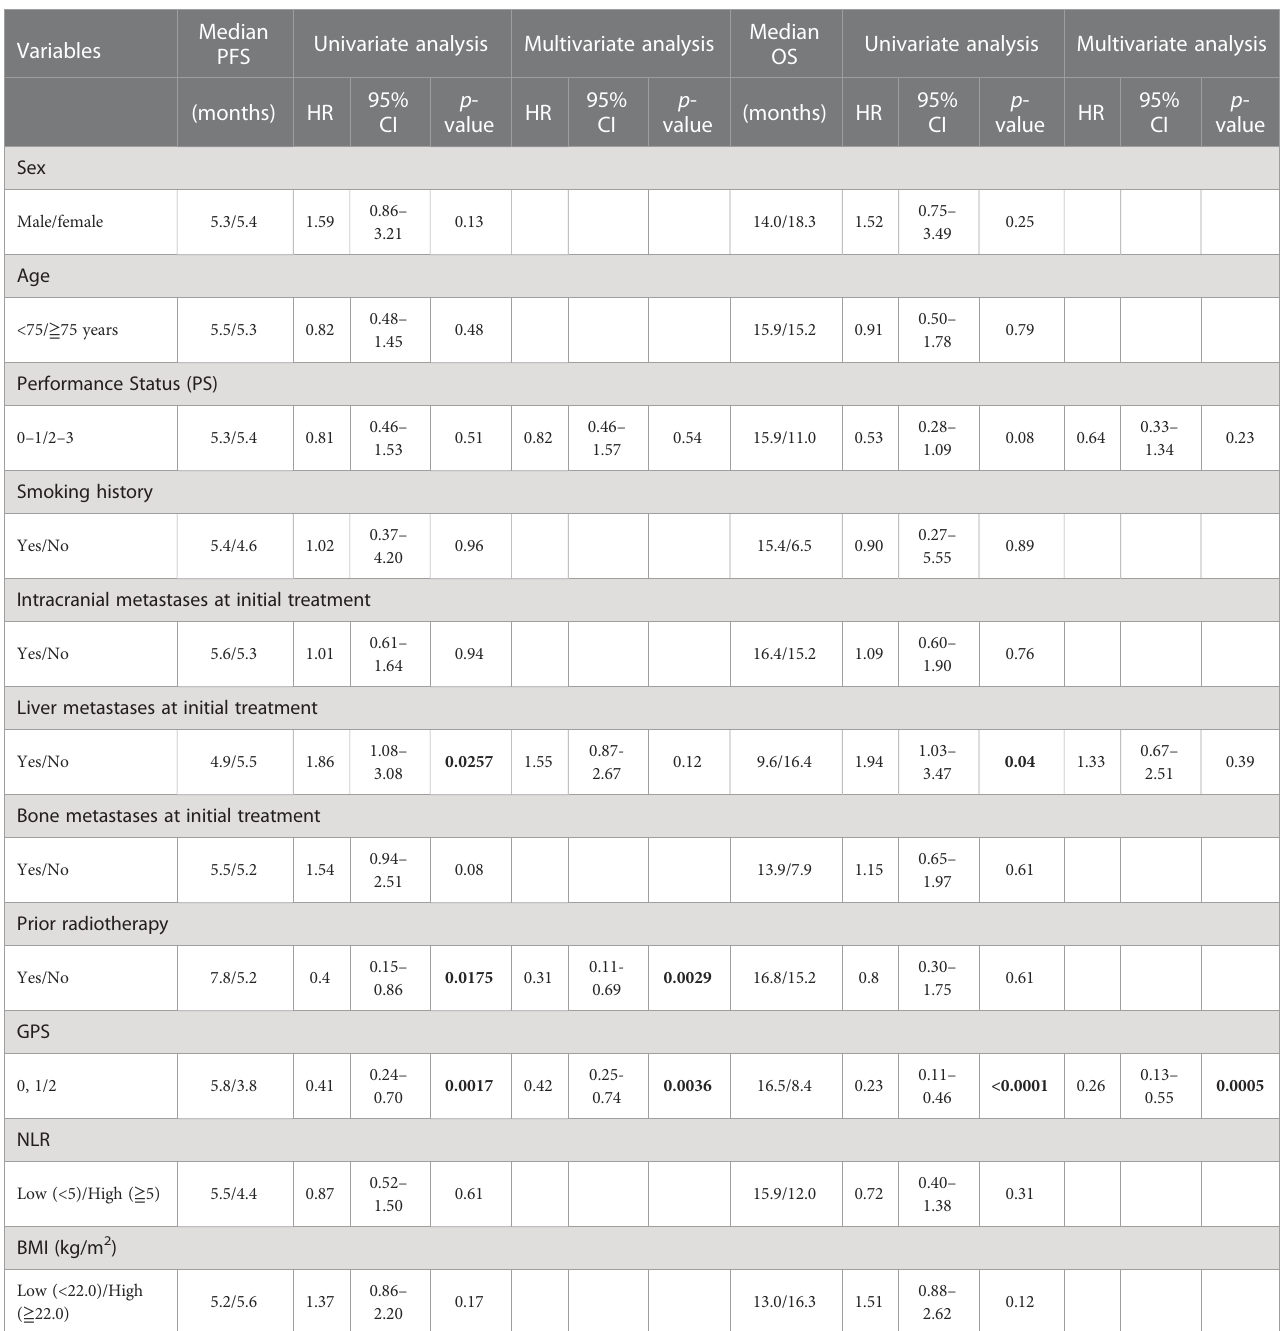
TABLE 4 Univariate and multivariate analyses of PFS and OS. Median Univariate analysis Multivariate analysis Variables PFS